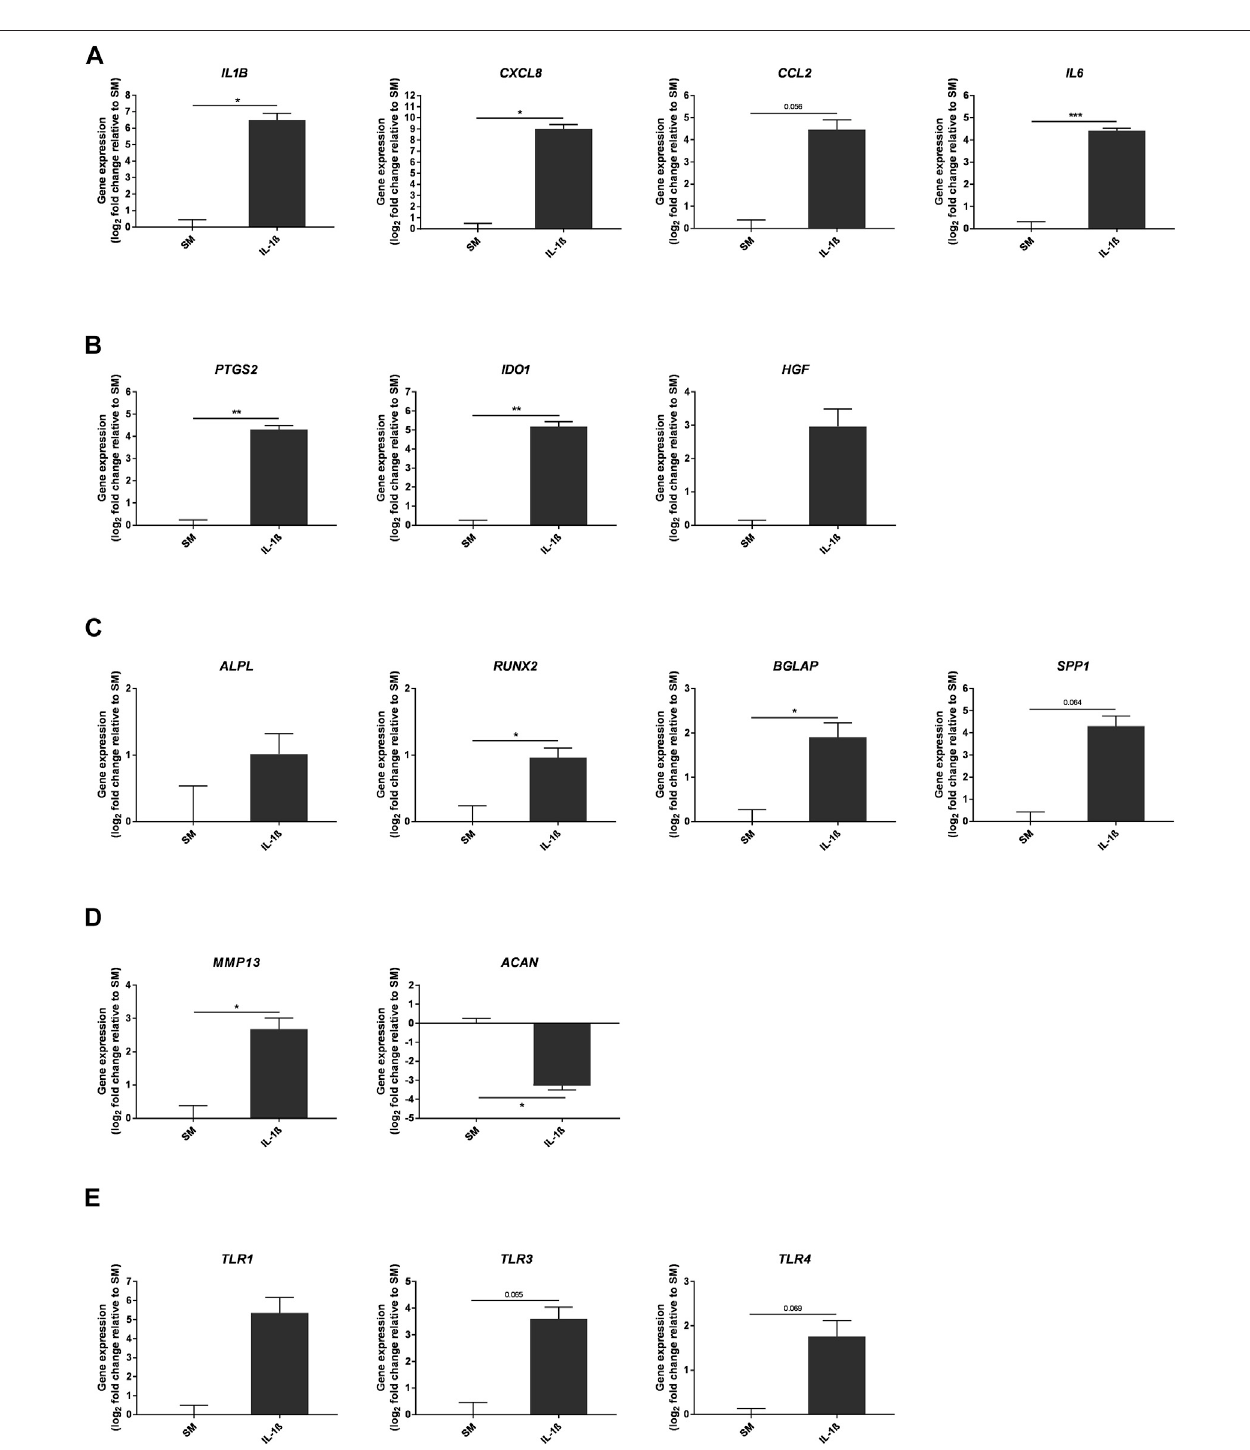
FIGURE 6 | Gene expression changes in response to IL-1 β (100 pg/ml) added to MSC cultures in SM over 10 days. Gene expression of pro-in fl ammatory (A) and immunomodulatory (B) mediators, osteogenic (C) and chondrogenic (D) factors, and toll-like receptors (E) . Data shown as log 2 fold change compared to SM control condition. Error bars represent SEM. n = 3, * p < 0.05, ** p < 0.01, *** p < 0.001.